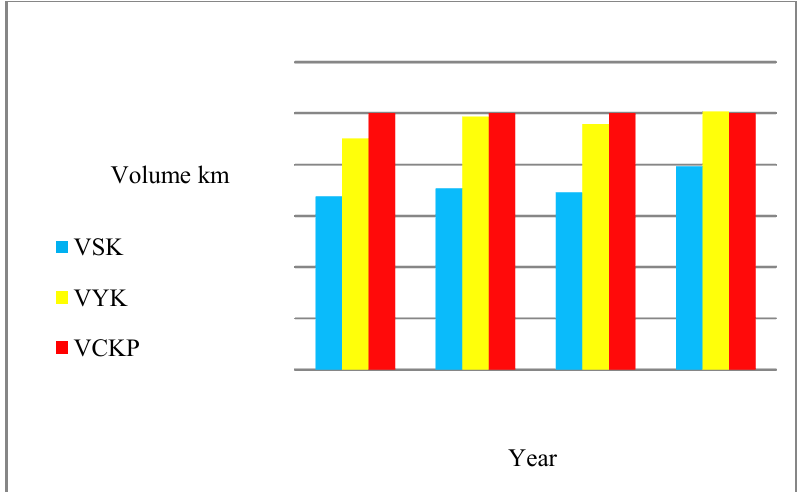
Fig.1. Correlation of total scope of training work in water (km) of Ya. Klochkoca and S. Kopchikova and targeted program of combined swimming Ukrainian